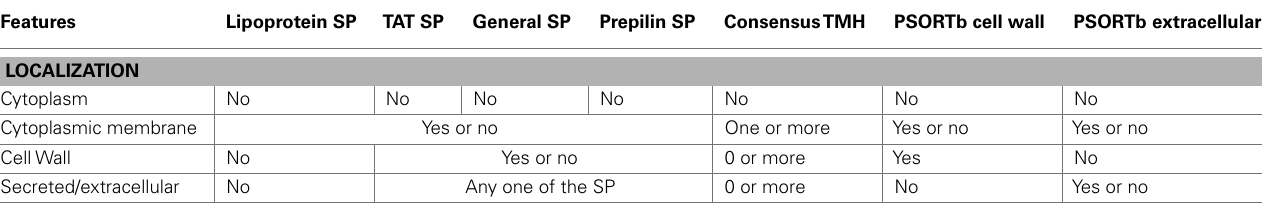
Table 3 | Logical rules used for archaeal SCL